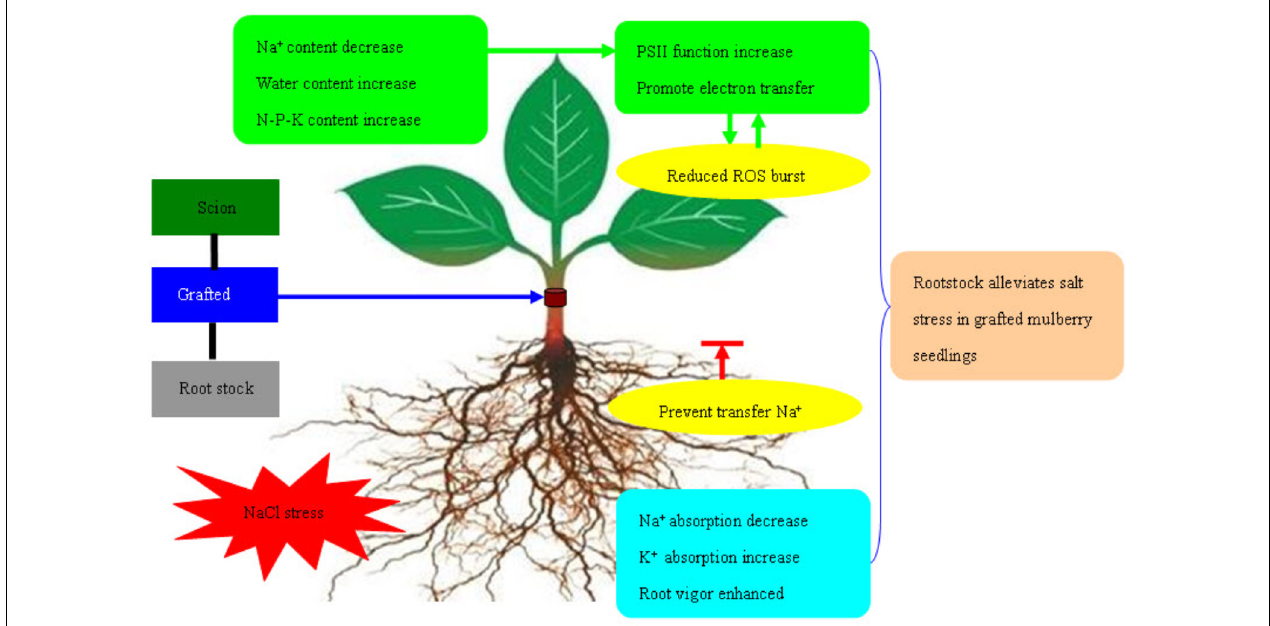
FIGURE 8 | The mechanism of rootstock alleviates salt stress in grafted mulberry seedlings.